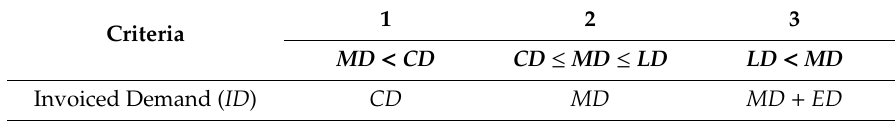
Table 2. Criteria for determining Invoiced Demand